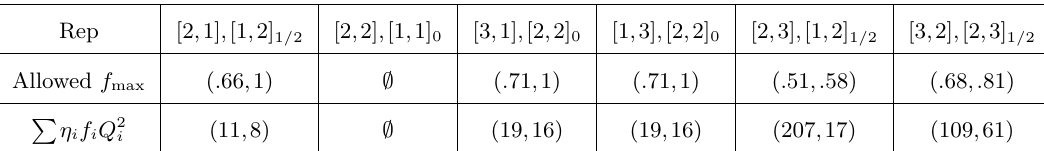
Table 8 . Examples of the allowed f max for new fermionic fields if they are the only new contribution to the S parameter. Also shown is the range of values of P η vector-like mass is taken to be the same for both fermions involved in the Yukawa interaction; this gives a weaker bound than allowing two different vector-like